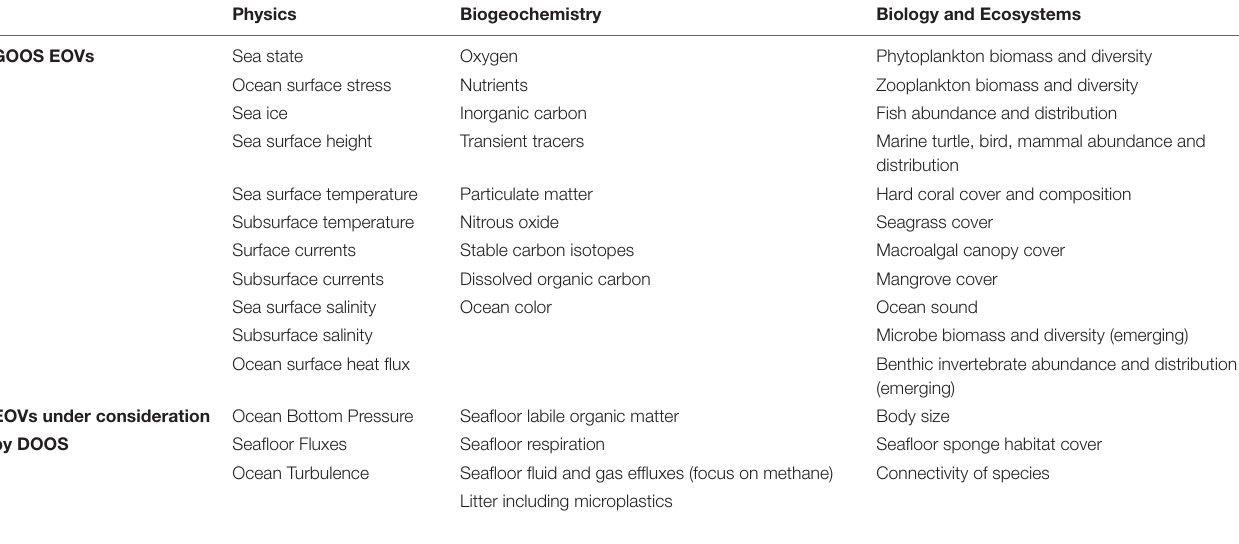
TABLE 2 | Global Ocean Observing System (GOOS) Essential Ocean Variables (EOVs) and new EOVs proposed by the Deep Ocean Observing Strategy